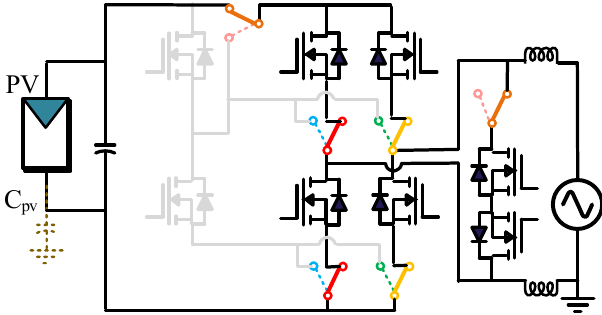
Figure 3. Configuration in the healthy mode of the IFTPVI.